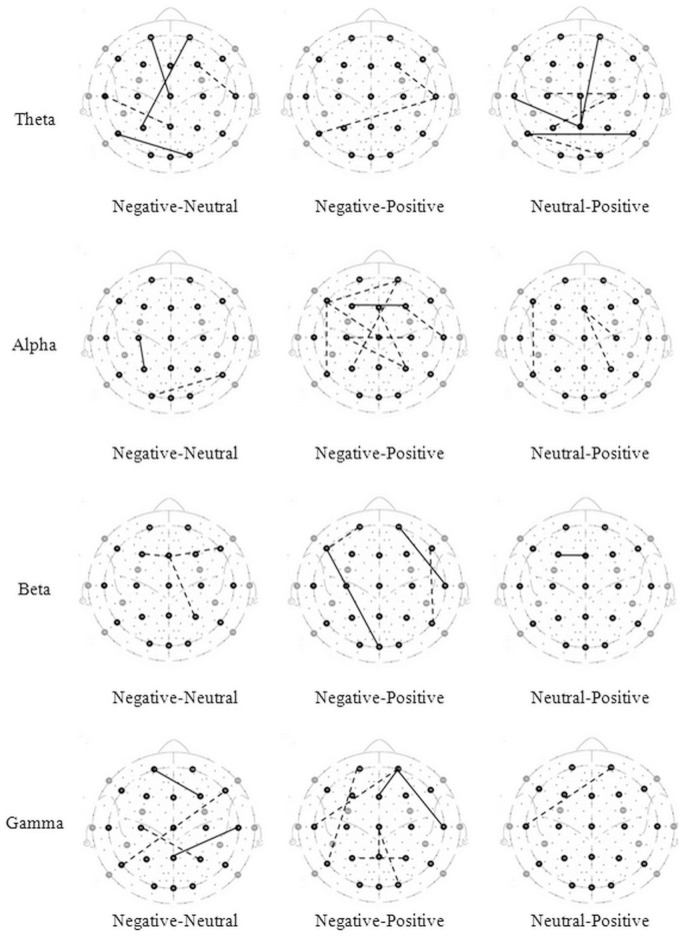
Brain maps of phase synchronization index.The lines connecting electrode sites indicate significant higher (solid) and lower (dashed) of phase synchronization index for condition listed on left site.